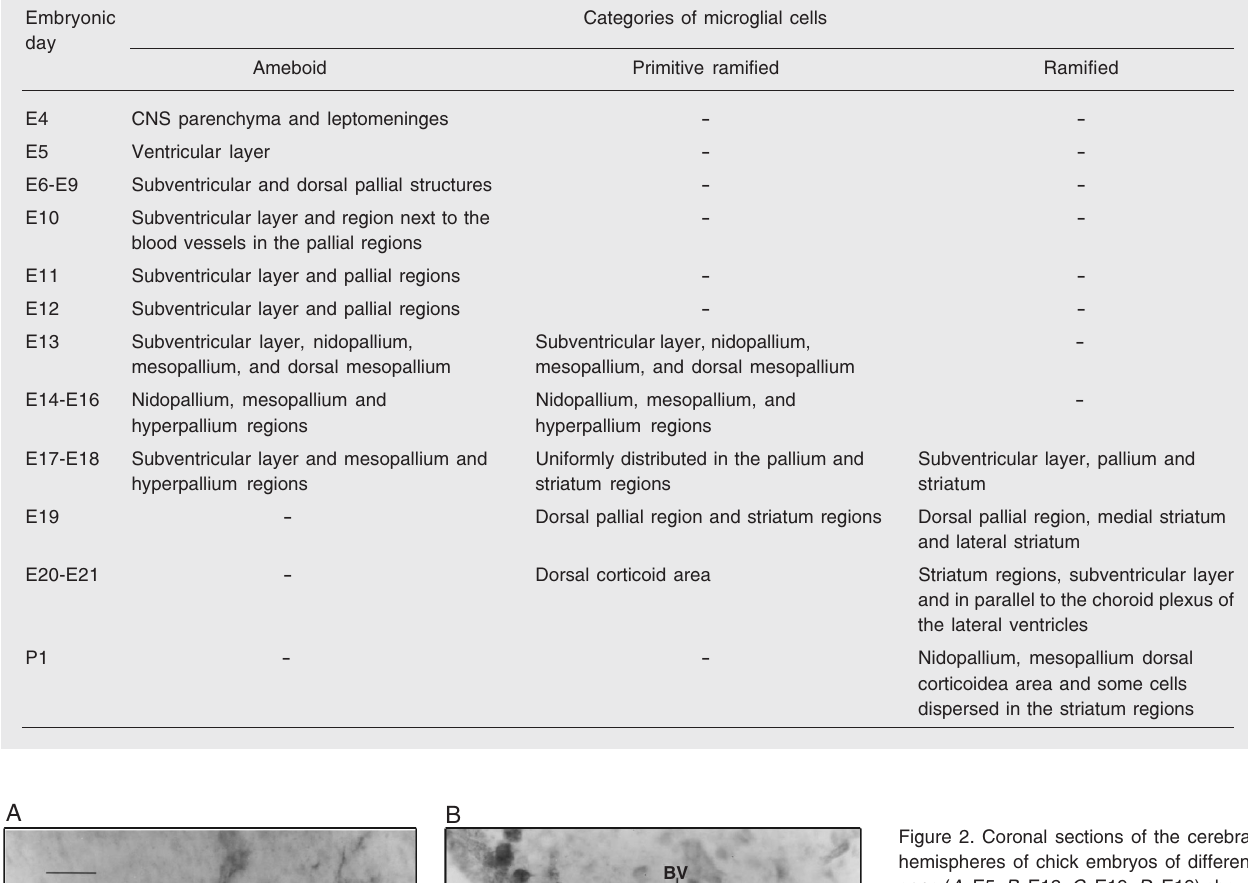
Figure 2. Coronal sections of the cerebral hemispheres of chick embryos of different ages ( A , E5; B , E12; C , E19; D , E19) show- ing lectin-reactive cells. LV = lateral ven- tricle; AM = ameboid microglial cell; PRM = primitive ramified microglial cell; RM = ramified microglial cell; BV = blood vessel. Scale bars: A, B, C = 22 µm; D =